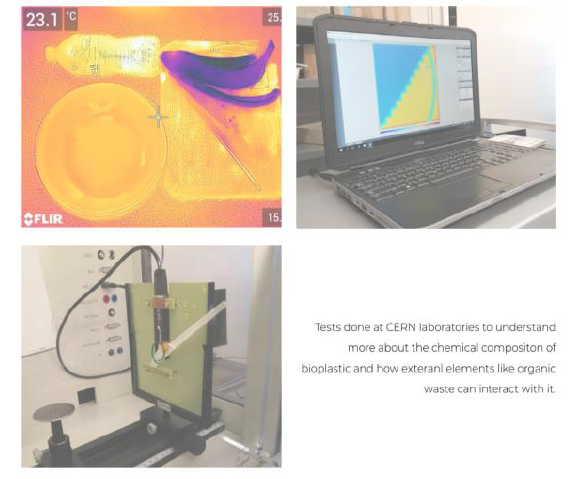
Fig. 10. AIMAG Experiments with Thermal Infra-Red (TIR) at